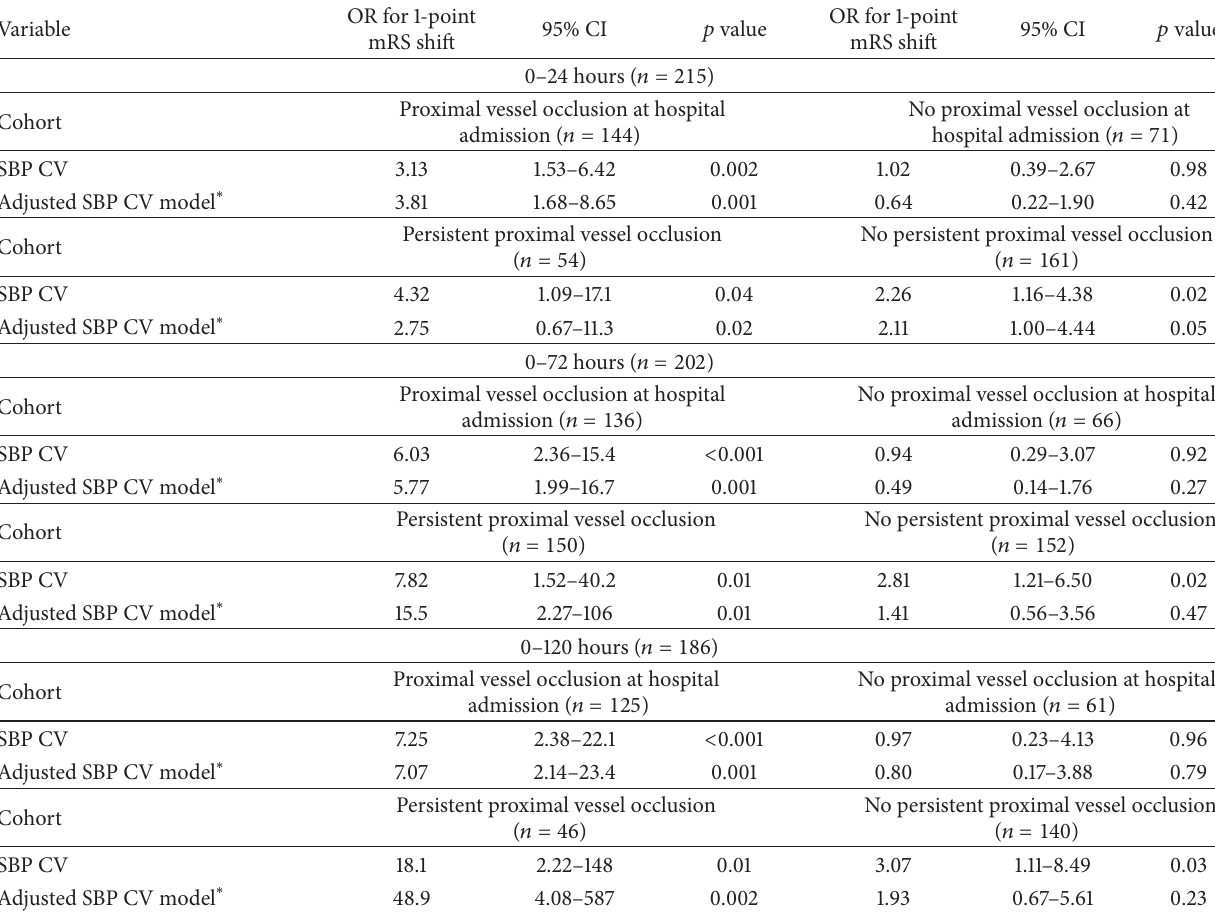
Table 4: Ordinal logistic regression models fitted to a one-point shift in mRS, stratified by proximal vessel occlusion at hospital admission and persistent proximal vessel occlusion, with predictor variables of SBP CV and SBP CV in a multivariable model.